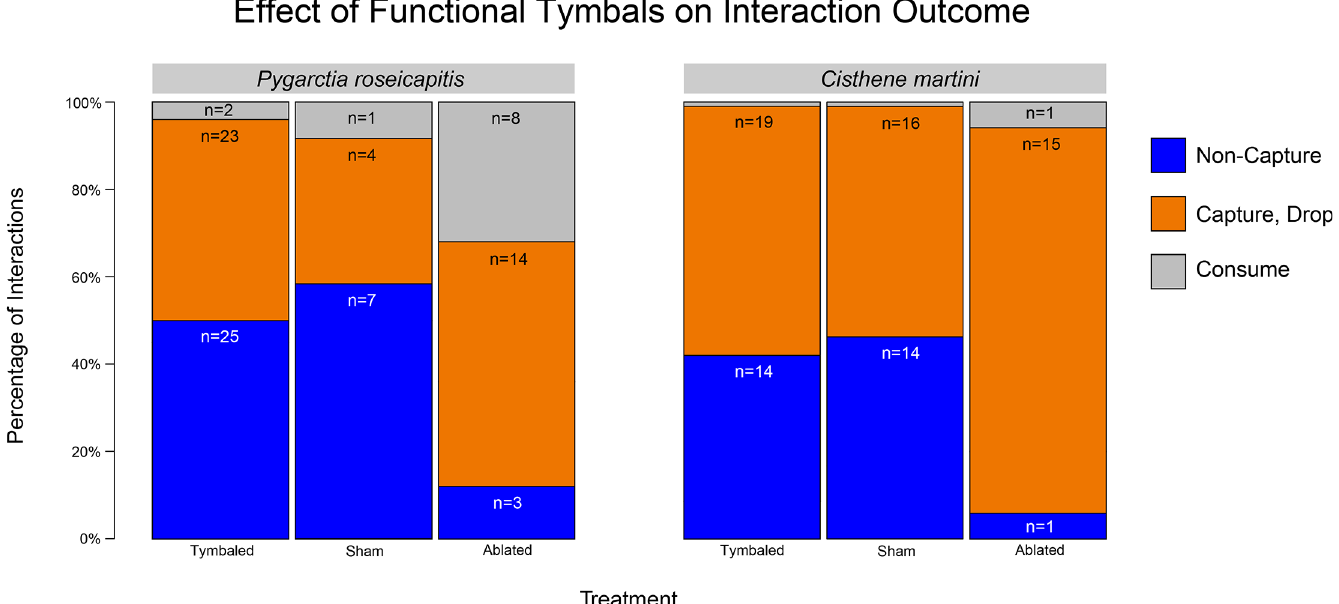
Fig 2. Effect of functional tymbals on the outcomes of bat-moth interactions for Pygarctia roseicapitis and Cisthene martini . The percentages of interactions for each possible outcome recorded for each treatment group. Numbers within each bar indicate the number of interactions observed for that treatment/outcome